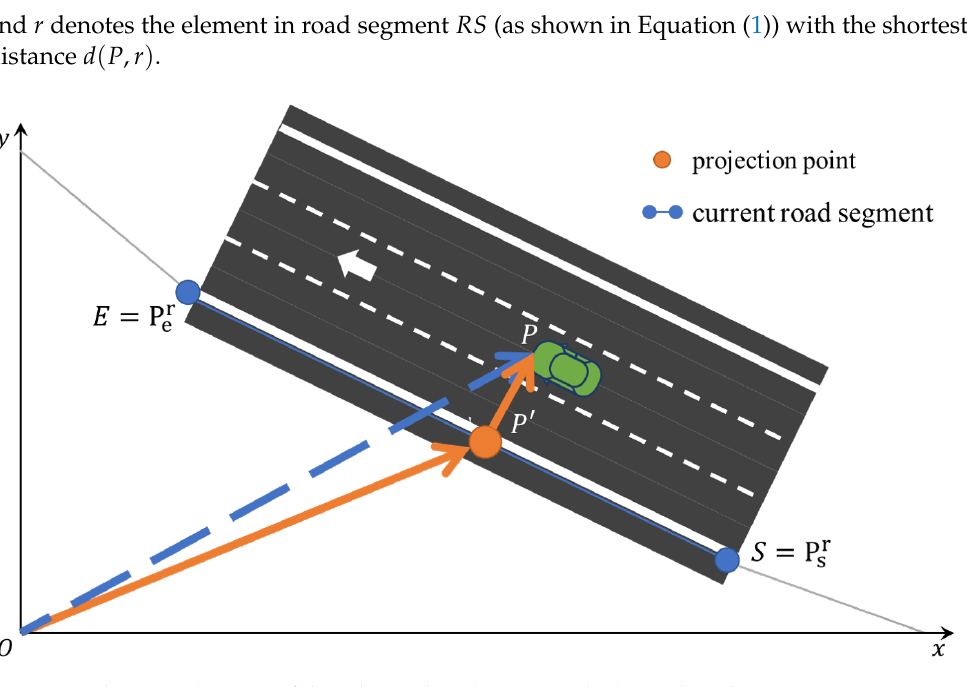
Figure 3. Schematic diagram of the relationships between vehicles and road